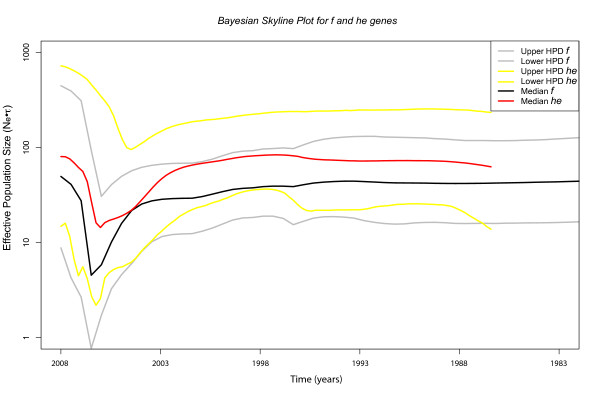
Bayesian Skyline Plot reconstruction for the f and he genes. Black and red lines represent median estimates of effective population size, scaled by generation time in years (τ), for the f and he genes, respectively. Grey and yellow lines represent 95% Highest Probability Density (HPD) for both genes with grey for f and yellow for he, respectively.